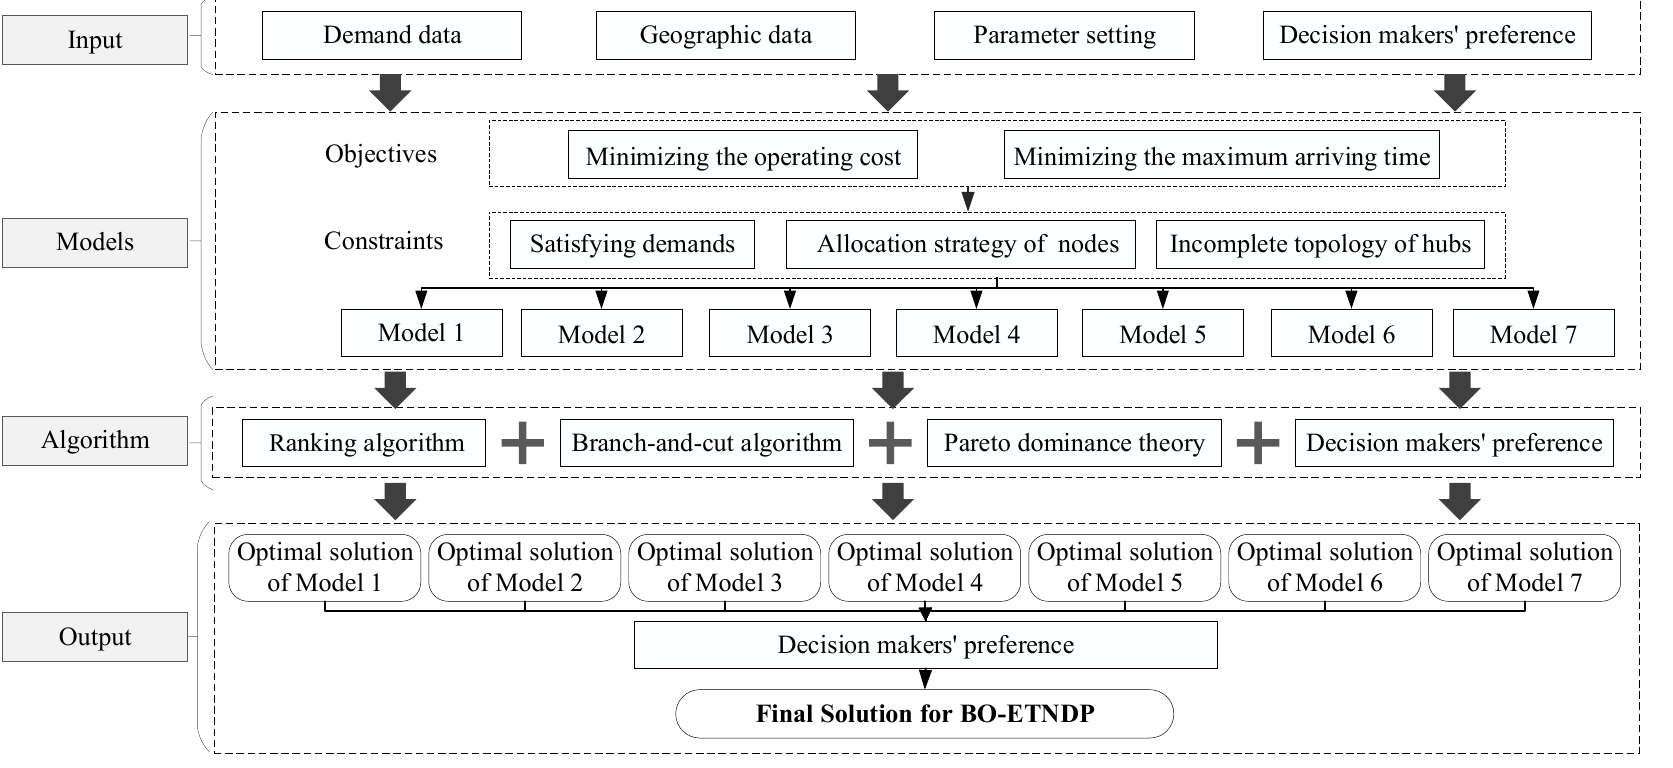
Fig. 2. Framework of the